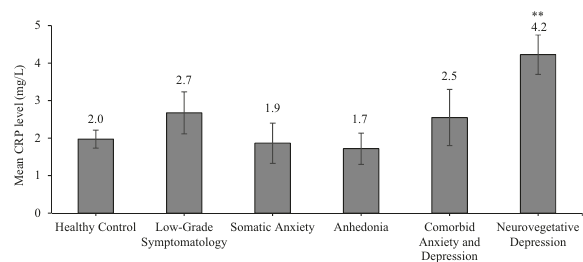
Fig. 3 Basal levels of CRP according to symptom cluster (mean ± standard error). ** p < 0.01 compared to healthy control, somatic anxiety, and anhedonia Fig. 2C, only the anhedonia, p < 0.001, comorbid anxiety and depression, p < 0.001, and neurovegetative, p < 0.001 clusters signi fi cantly differed compared to healthy controls.